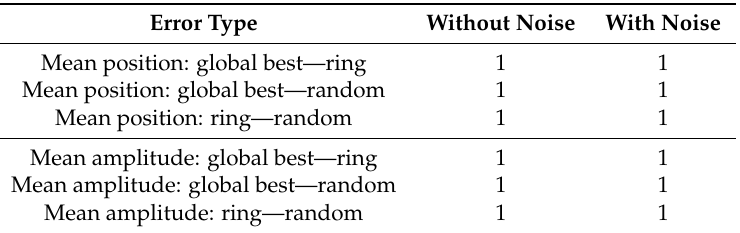
Table 5. Two-sample Kolmogorov–Smirnov test for comparison distributions (0—rejection of the null